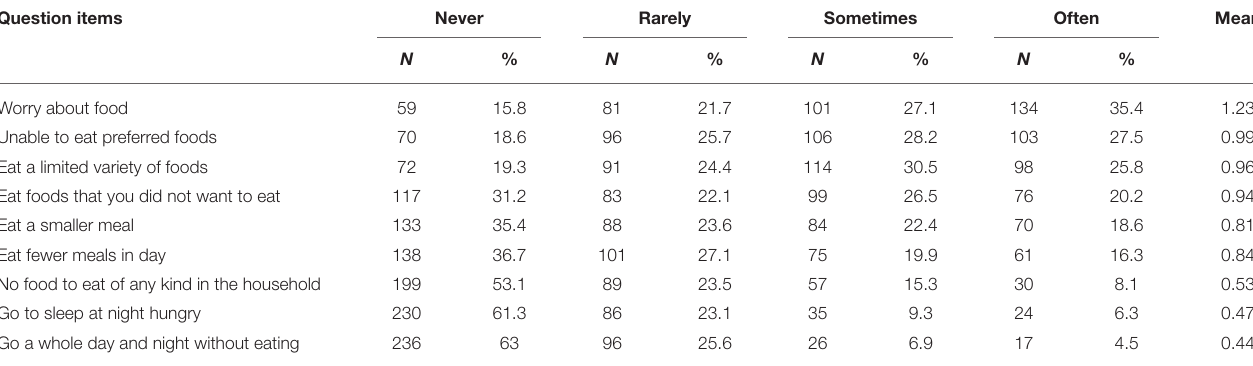
TABLE 1 | Results of the HFIAS questionnaire of the studied households. Question